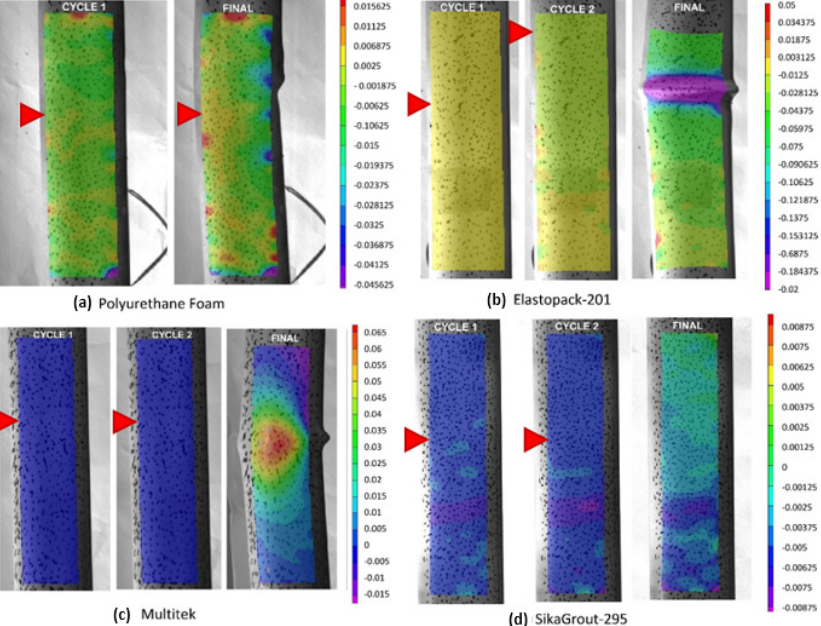
Figure 8. Deformations ε y (µm/m) at the maximum load of cycle 1 and cycle 2 and at the end of the test in each of the hybrid elements tested; core filler materials: ( a ) Polyurethane foam, ( b ) Elastopack-201, ( c ) Multitek and ( d ) Mortar (SikaGrout-295). Red arrows indicate loci of maximum strain at peak loads.